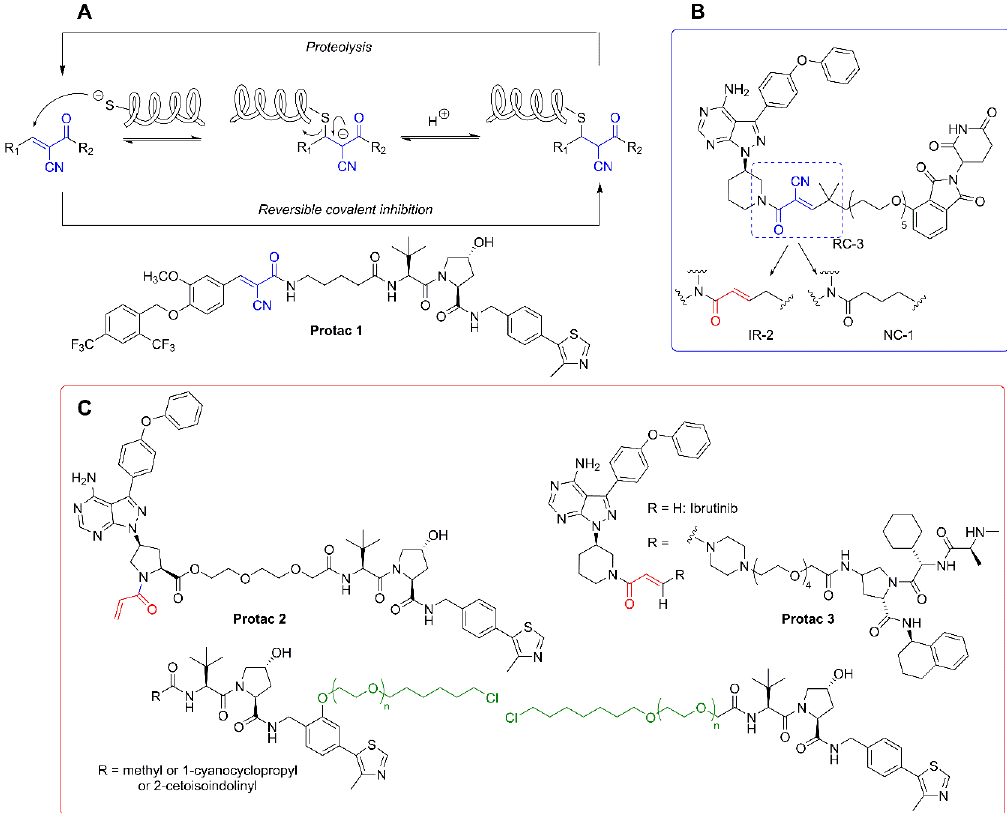
Figure 5. ( A ) Top: illustration of the concept of reversible covalent inhibition and application to the design of a protac against the ERRα (protac 1). ( B ) Examples of non-covalent (NC-1), irreversible covalent (IR-2) and reversible covalent (RC-3) protacs against BTK. ( C ) Examples of covalent protacs designed as BTK degraders. The Michael acceptor moiety, used as a warhead, is marked in red.